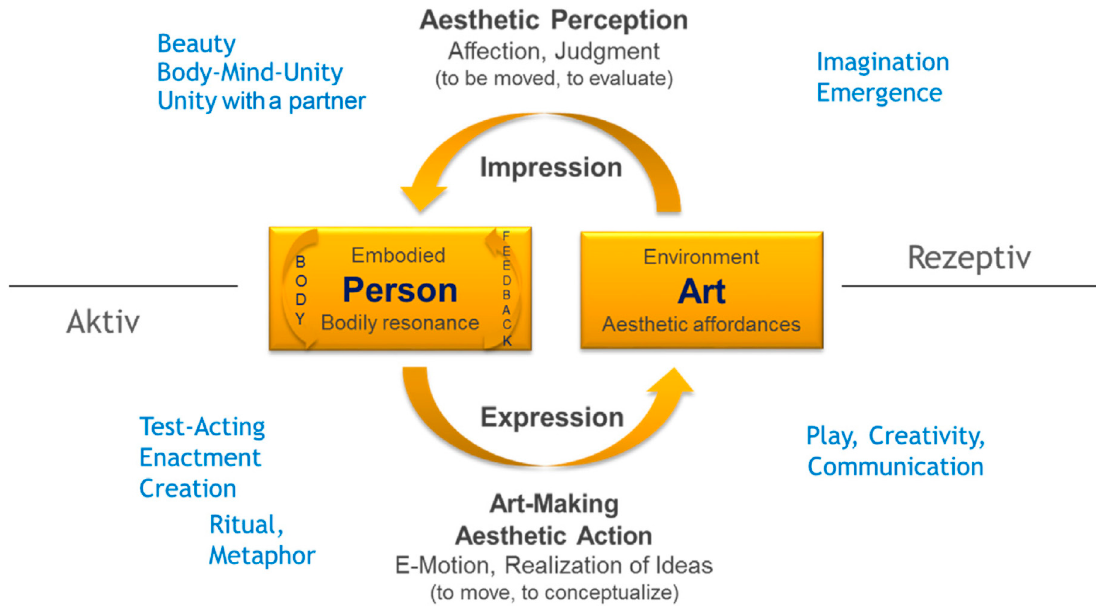
Figure 1. The Model of Embodied Aesthetics with loosely assigned therapeutic factors [2] (p. 89).